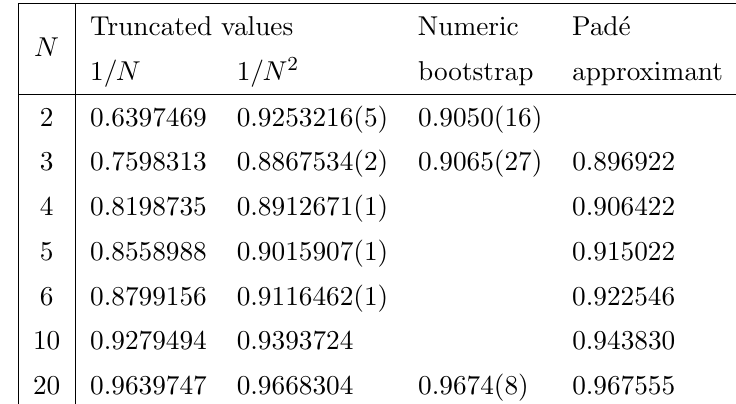
Table 2 . Evaluation of the truncated series in d = 3 for C J given in (3.54). The column 1 =N 2 contains the new results of this paper and show great improvement when compared to results from numeric bootstrap [49] and Pad(cid:19)e approximants (we use the Pad(cid:19)e of [38] which uses both the [3 ; 3] 4 (cid:0) (cid:15) and the 2 + (cid:15) expansions). For N = 2, C J =C J; free is related to the universal conductivity (cid:27) 1 of the 3d O(2) model [50] and has been estimated using Monte Carlo simulations to 0 : 914(10)